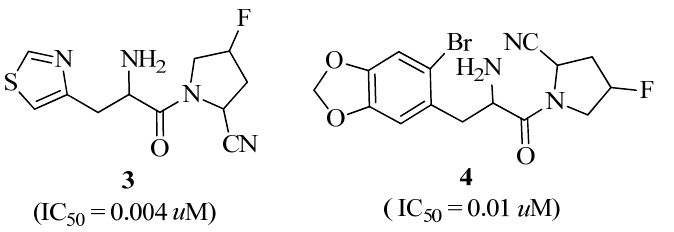
Figure 5. 1,2,3-Triazole-4-carboximidamide derivatives.